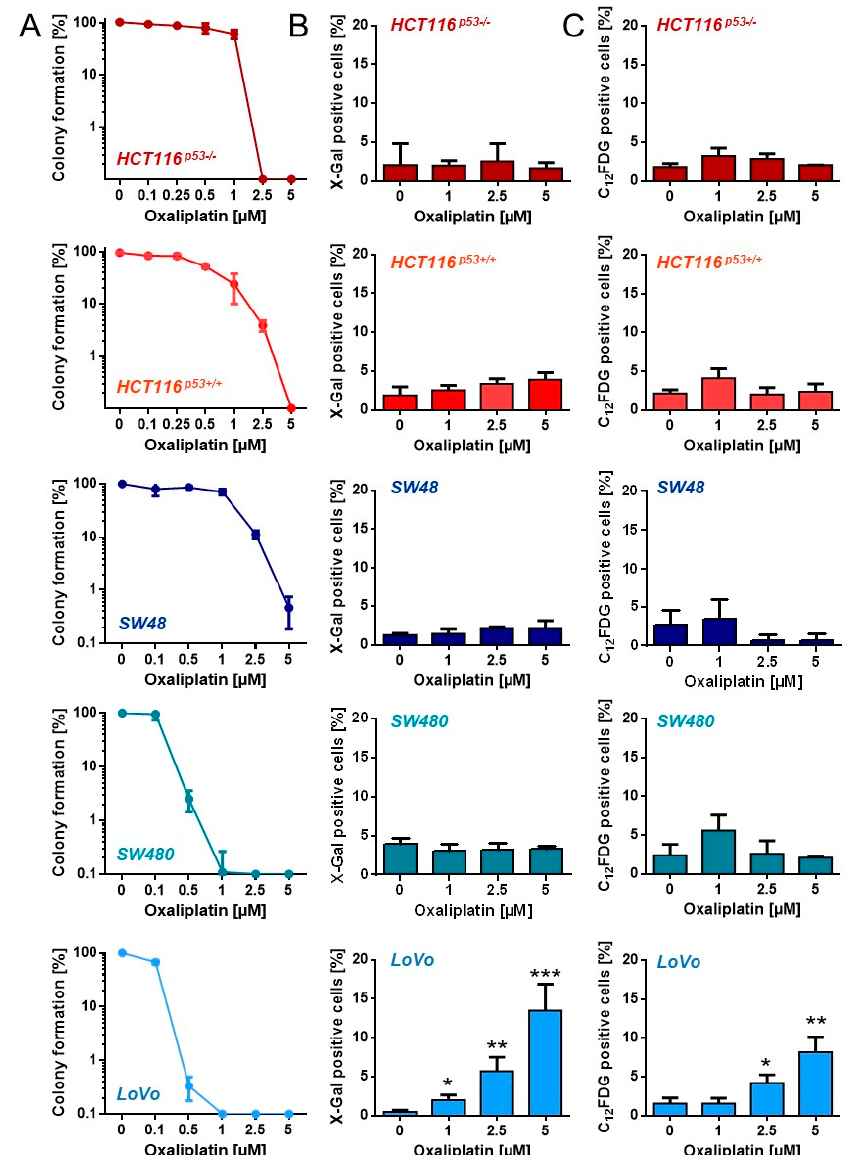
Figure 2. ( A ) Proliferation arrest was measured upon exposure to different oxaliplatin concentrations by CFA in CRC cells. ( B ) Senescence was measured microscopically by detection of β -Gal positive cells 120 h after oxaliplatin exposure. ( C ) Senescence was measured by flow cytometry using C 12 FDG staining 120 h after oxaliplatin exposure. ( B , C ) Experiments were performed in triplicates and differences between treatment and control were statistically analyzed using Student’s t test (not labeled = not significant, * p < 0.1, ** p < 0.01, *** p < 0.001).